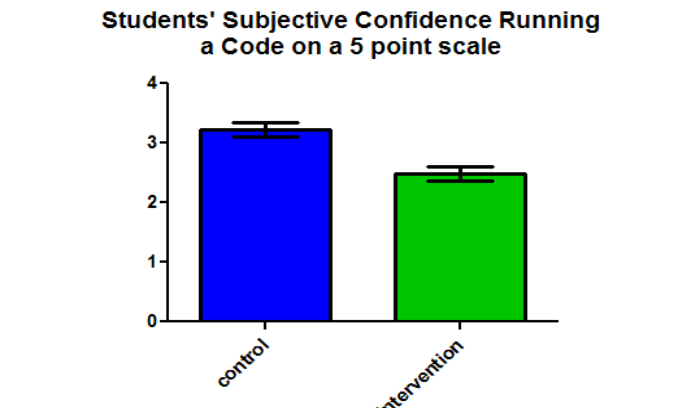
Figure 5. Students with access to computer based simulation had significantly lower subjective confidence in running a code than those without access [t(63)=4.19,